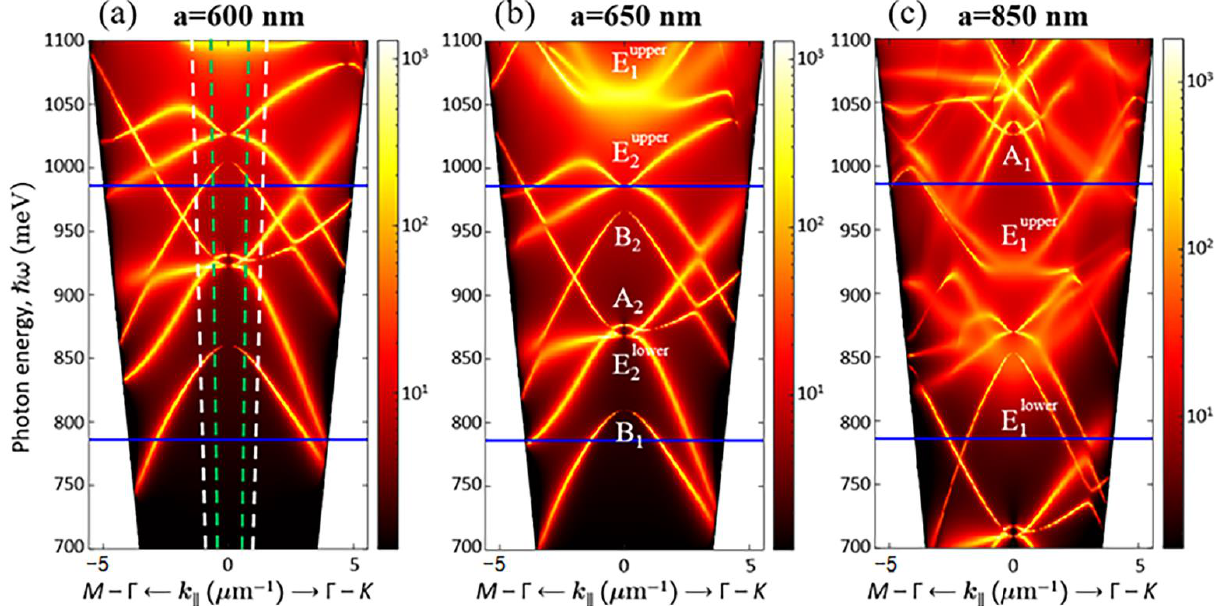
Figure 4. The emissivity dispersion dependences of PCS modes calculated for PCS with the periods a = 600 nm ( a ), 650 nm ( b ) and 850 nm ( c ). The dashed lines in figure ( a ) limit the signal collection angle in the micro-PL setup (white lines, 2 θ ~ 30°) and in the DPL setup for a diaphragm diameter of 10 mm (green lines, 2 θ ~ 15°). The first-order quasi-guided modes are marked in figures ( b ) and ( c ) according to [38]. Horizontal blue lines mark the energy range of PL signal related with Ge(Si) nanoislands.